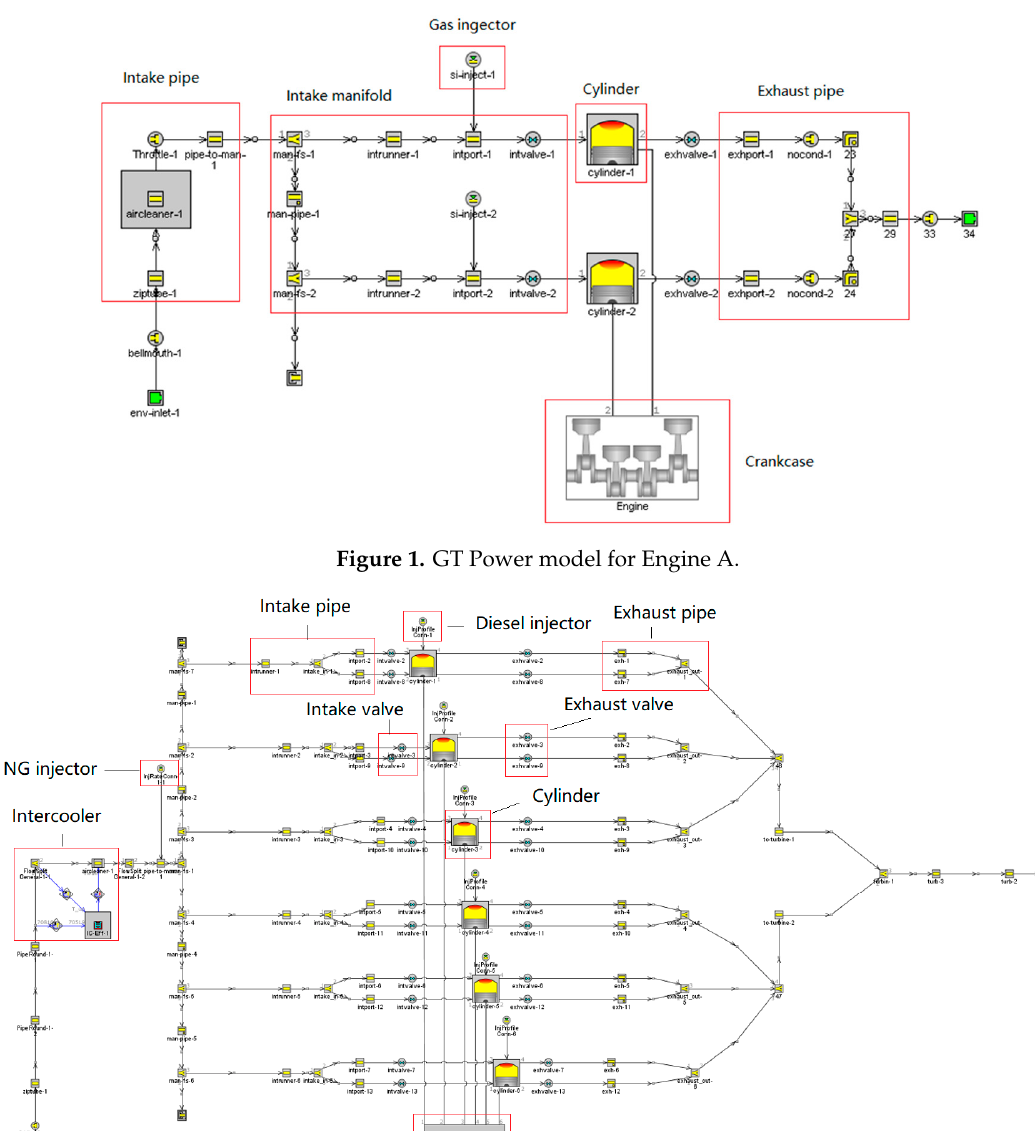
Table 1. Main characteristics of the investigated engines.